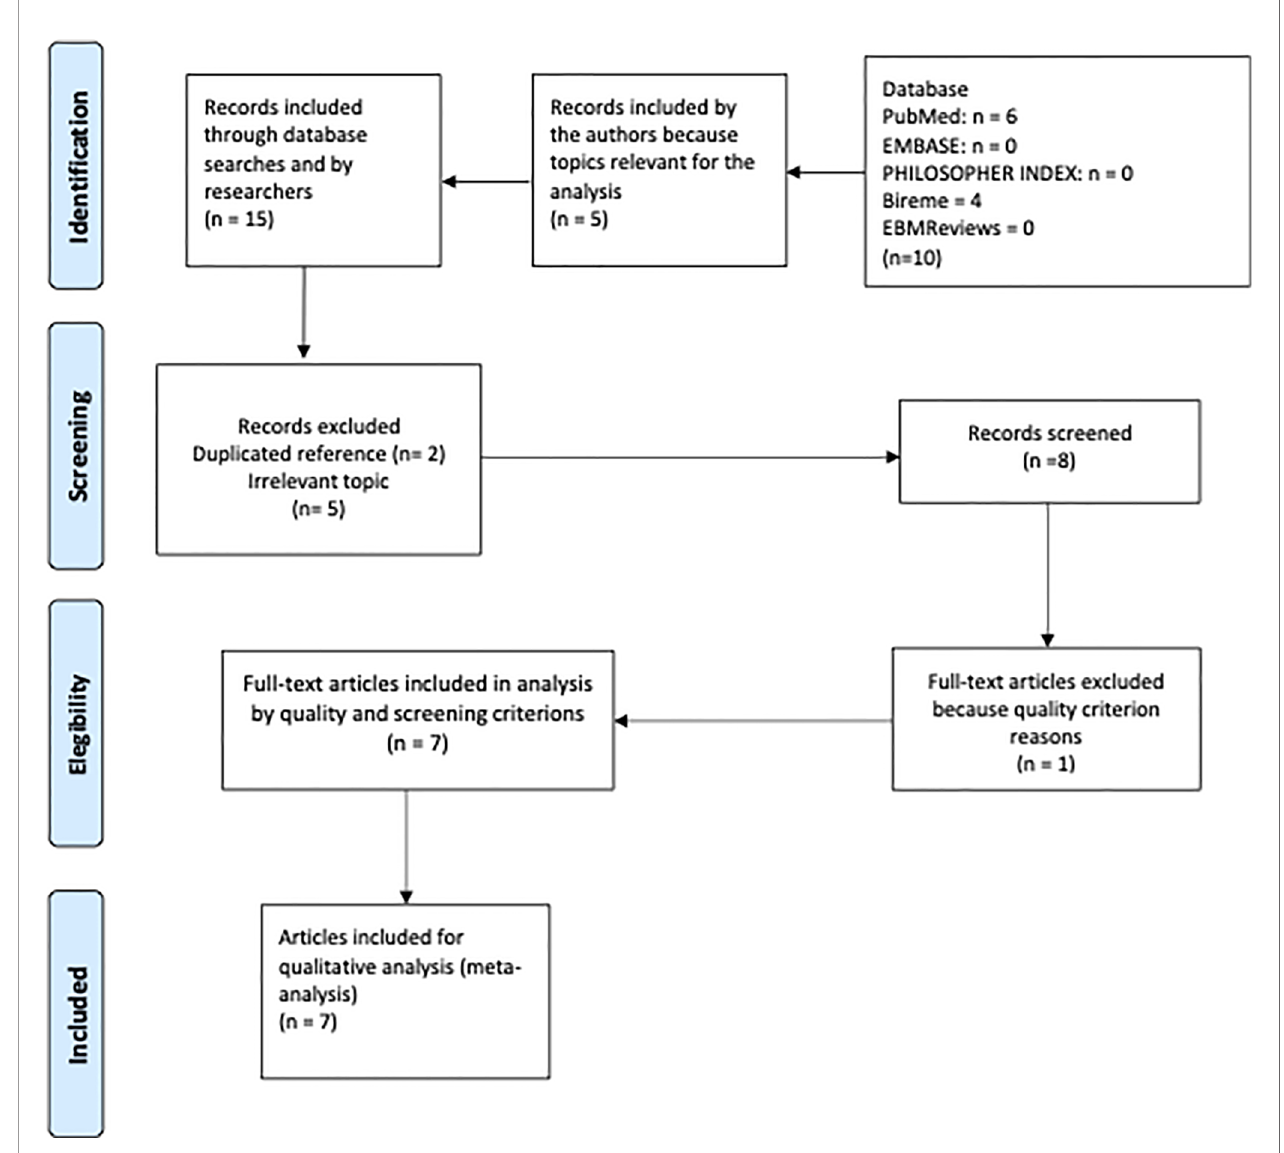
FIGURE 2 | PRISMA fl ow chart that shows the selection process used to retrieve the fi nal 7